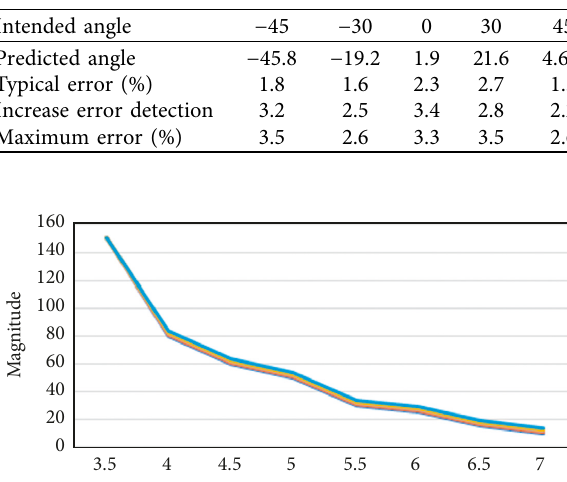
Table 2: Approaching angle detected based on the designed angle.